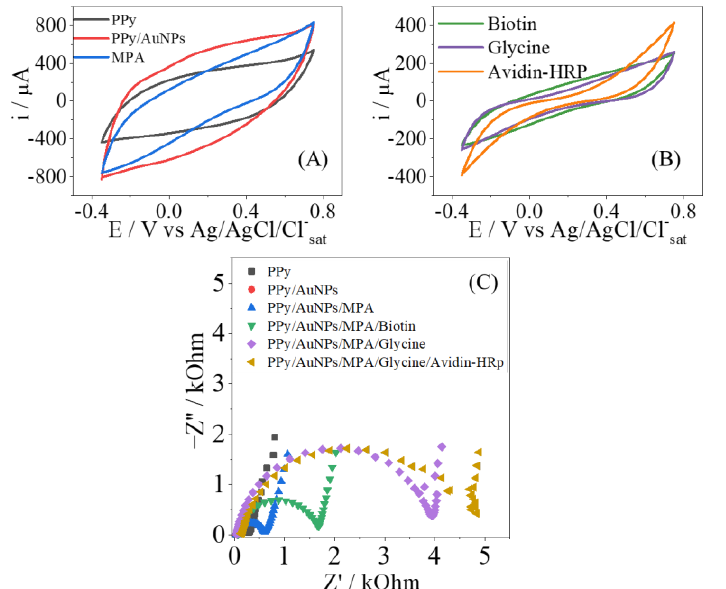
Figure A2. Characterization of the PPy/AuNPs-based biosensor construction steps for the Avidin- HRP/Biotin couple. Cyclic voltammograms ( A , B ) show the characterization of different steps in the construction of the platform-based biosensor, and the Nyquist diagram ( C ) is for the same charac- terization. Table A1. Parameters ’ values obtained by EIS to PPy e PPy/AuNPs, in electrode modification steps.